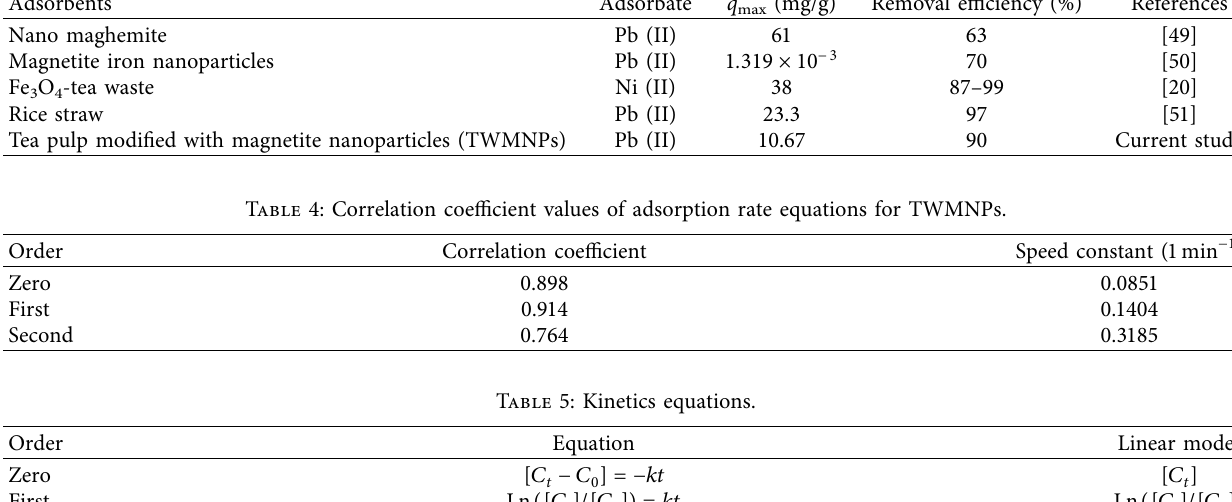
Figure 10: Pb (II) adsorption isothermal models by TWMNPs: (a) Langmuir and (b) Freundlich. Table 3: Adsorption capacities q max (mg/g) for Pb (II) of various adsorbents. Adsorbents